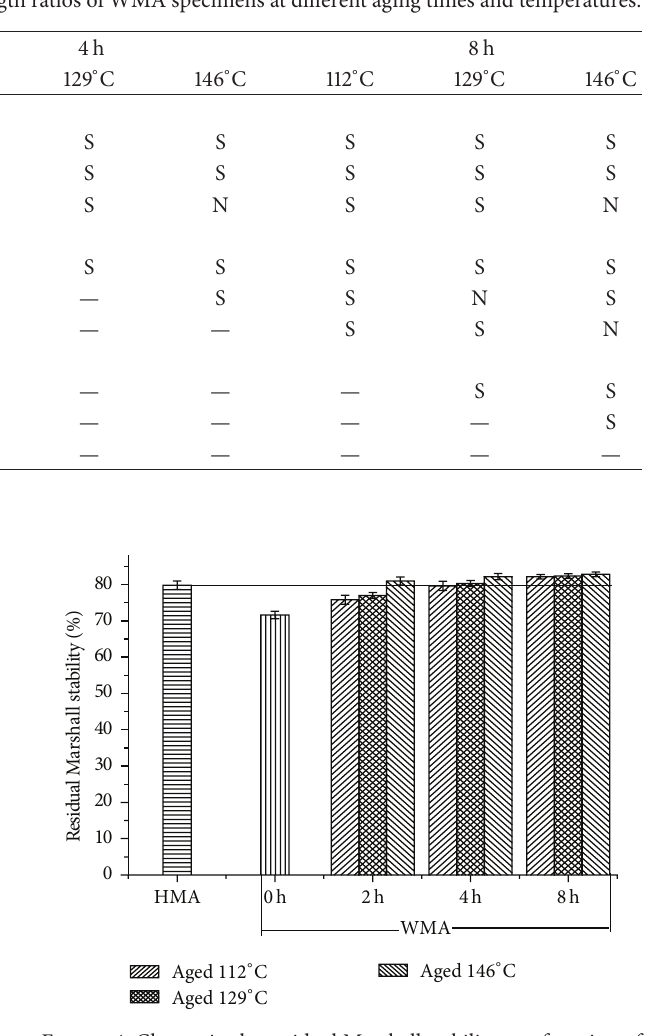
Figure 4: Change in the residual Marshall stability as a function of aging temperature and